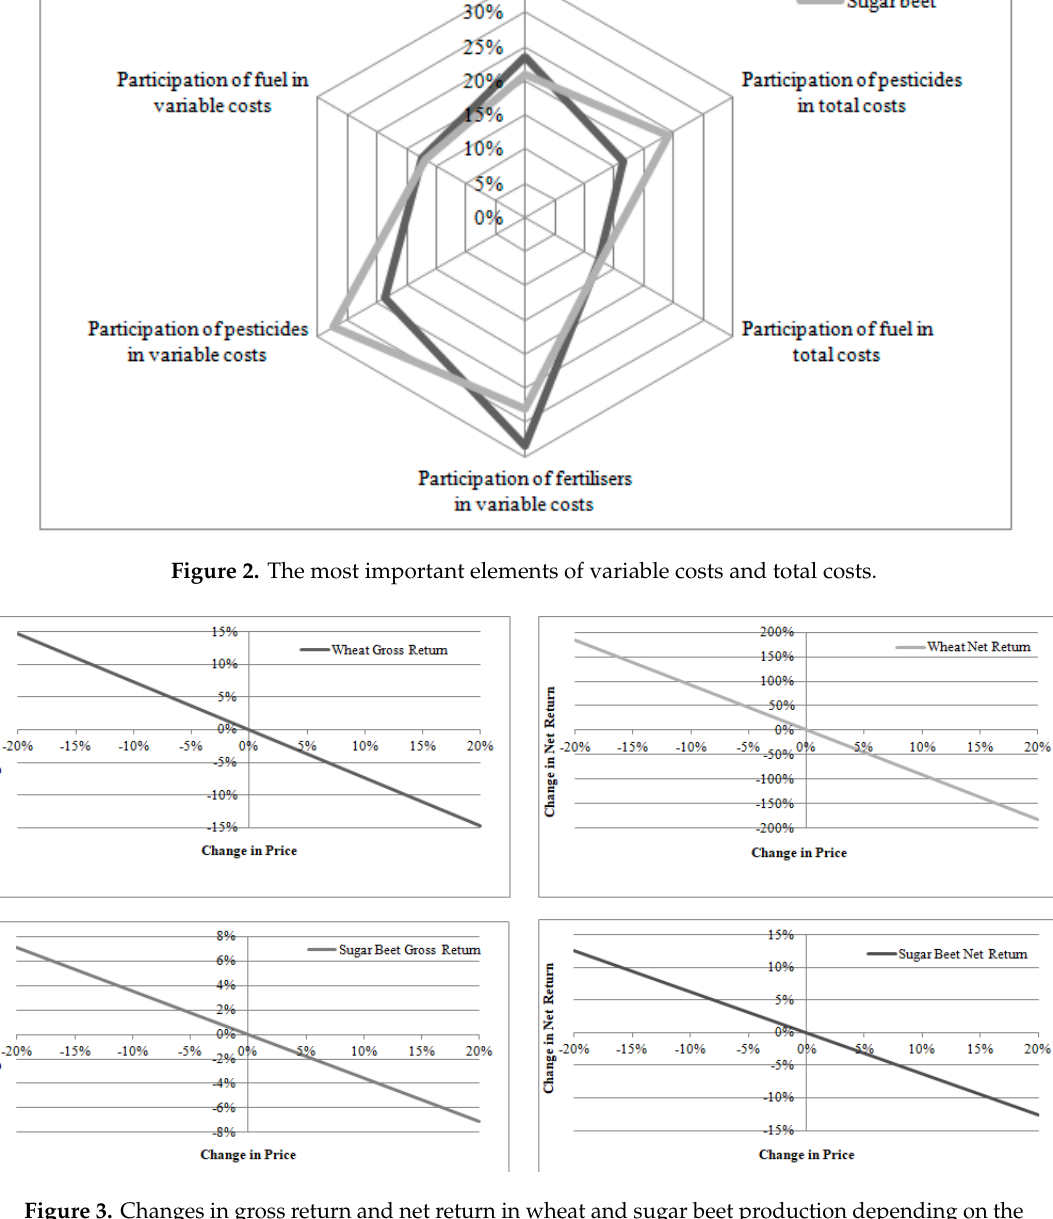
Table 5. The impact of the percentage change of the fertilizers’ prices on the percentage change in the gross return and net return in wheat and sugar beet production.